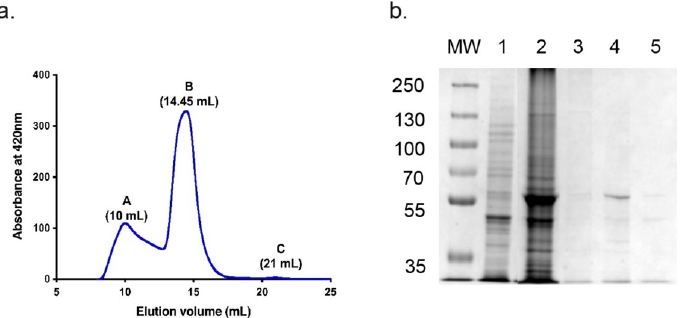
Figure 3. SEC fractionation of Ni-NTA affinity-purified CnCYP51-6 × His. ( a ) SEC elution profile- absorbance at 420 nm. ( b ) SDS-PAGE profile of the CnCYP51-6 × His purification. MW: 5 µ L molecular weight markers (PageRuler Plus pre-stained protein ladder, Thermo Scientific). Lane 1: